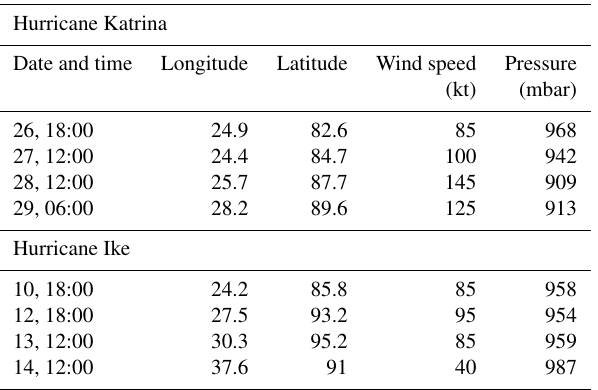
Table 1. Historical hurricane tracks for Hurricane Ike (2008) and Hurricane Katrina (2005).